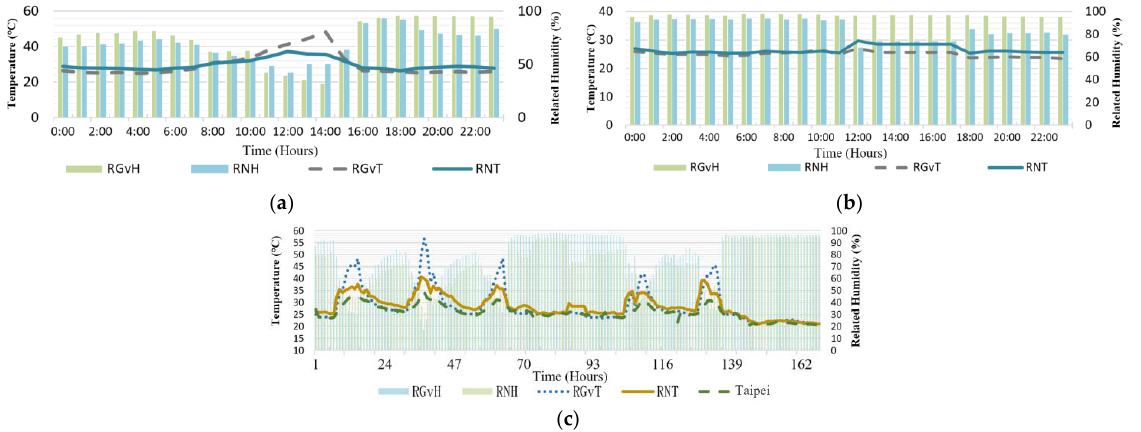
( d ) Figure 8. Temperature of Type A and Type B permeable brick pavement ( a ) 10 cm underground ( b ) partial observation on 21 May at 10 cm underground ( c ) above ground ( d ) partial observation on 21 May above ground. 3.3. Analysis of Data from Greening Rooftop Figure 9a,b present data from two consecutive days: 12 May and 13 May. From 10:00 am to 2:00 pm, the values from RGvT, a region with plants, were higher than those of RNT. According to observation data from the CWB, at approximately 5:00 pm on 12 May, it rained. At that time, the temperature dropped to approximately 20 °C, and the humidity increased to 90%. The next day, 13 May, it also rained at times (e.g., at 1:00 am and 6:00 am); thus, the temperature and humidity exhibited a horizontal trend. At 12:00 pm, the sunshine intensity increased, resulting in a decrease in the amount of water vapor in the air. Regarding the data in the region with plants, because the water vapor above the soil dissipated slower and because it did not rain afterward, the temperature exhibited a slight difference. Figure 9c presents the temperature and humidity data for the greening rooftop. The analyzed period was 7 days, from 10 May to 16 May. Curves